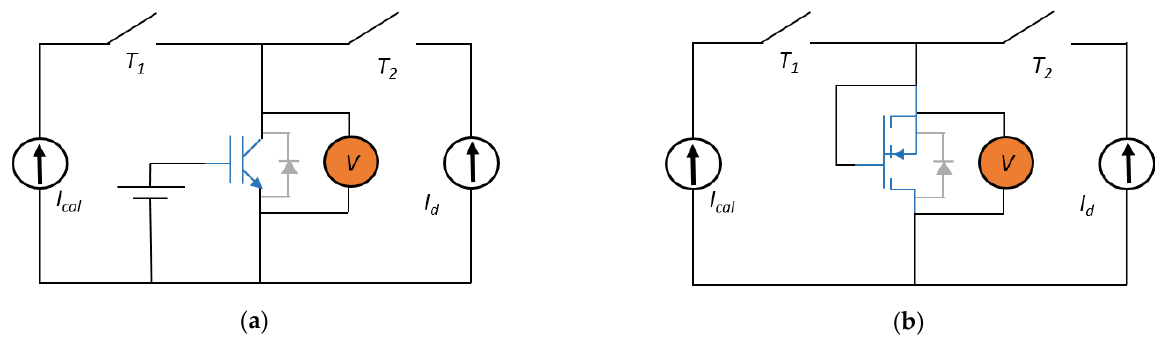
Figure 7. Electrical circuits for the static measurement of the voltage under a low current: ( a ) IGBT and ( b ) MOSFET.